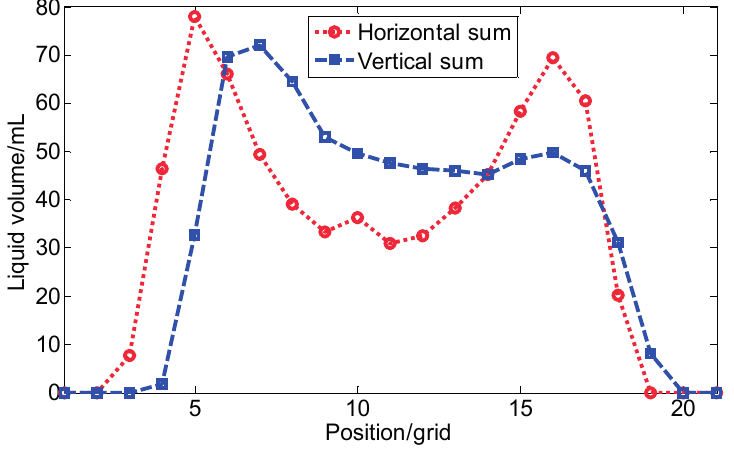
Figure 9. Horizontal and vertical sum statistics of flow distribution of Teejet AITXA 8004